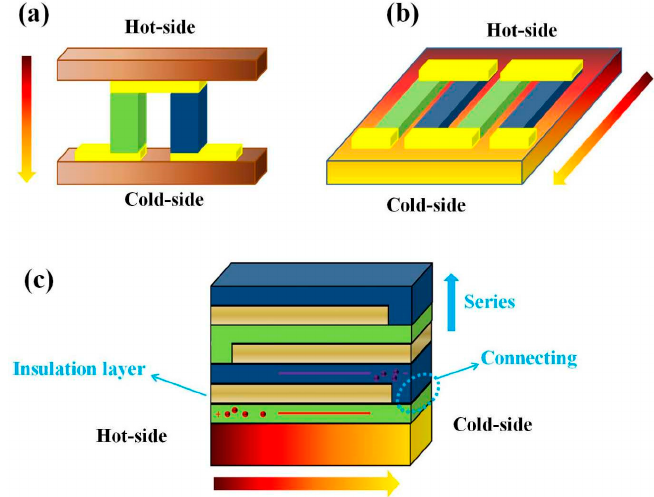
Figure 1. The structure schematic of the thin-film thermoelectric (TE) device (TFTED): ( a ) across-plane, ( b ) in-plane, and ( c ) multilayer structure.